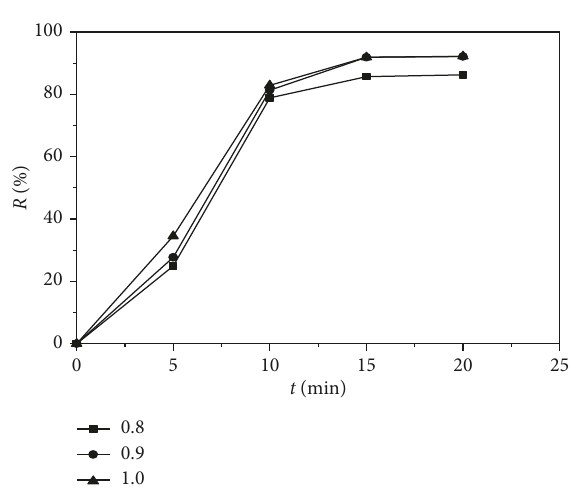
Figure 4: Plot of reduction degree of pellets blended with different biomass chars at 1200 ° C against time.